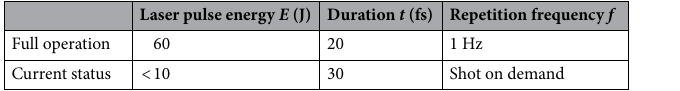
Table 1. Main ATLAS3000 laser parameters available for the LION experiment, considering full operation and current